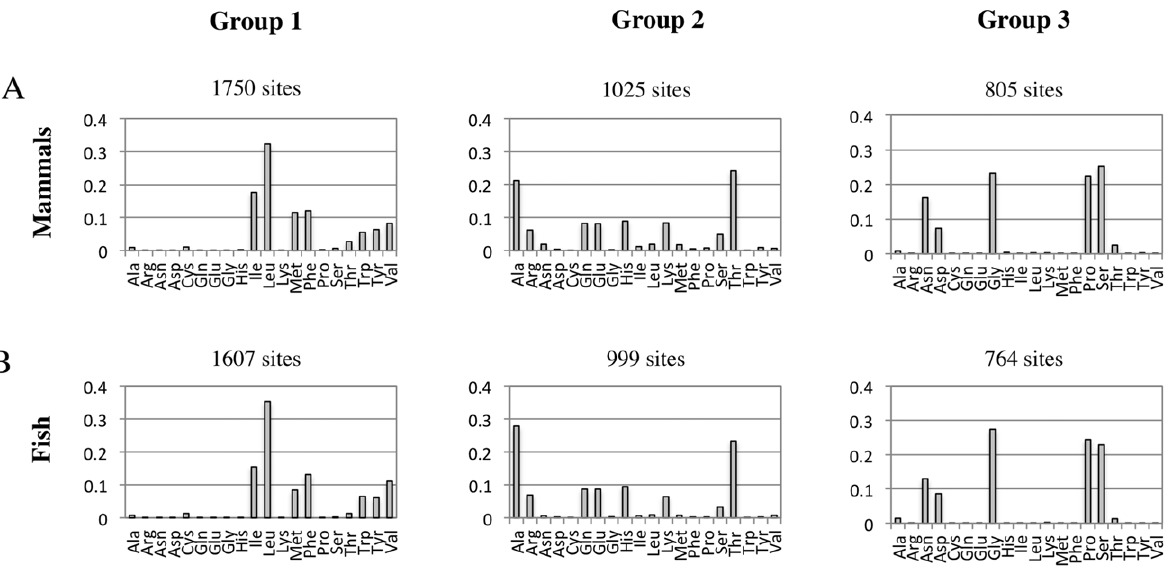
Figure 2. Amino acid composition of groups of sites resolved by K-means clustering on physiochemical properties. The amino acid frequencies in the mammal ( A ) and fish ( B ) datasets differ substantially among the groupings. The mammal dataset is comprised of 3580 MSA sites from 143 mitochondrial genomes and the fish data is comprised of 3370 MSA sites from 75 mitochondrial genomes. Amino acid frequencies are shown for each group of sites.